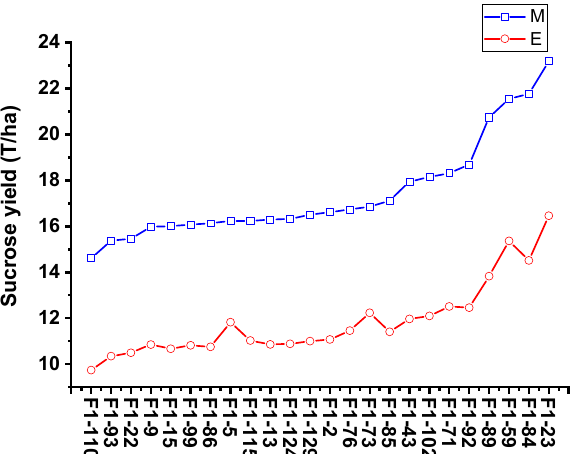
Figure 6. Comparison of the measured mean sucrose yield and estimated sucrose yield distribution trends of 24 F 1 genotypes. E and M indicate the estimated and measured mean sucrose yield. The estimated sucrose yield of 24 F 1 genotypes were calculated using the measured stalk height (SH), stalk diameter (SD), stalk number (SN), and Brix (B) of seedling plant.